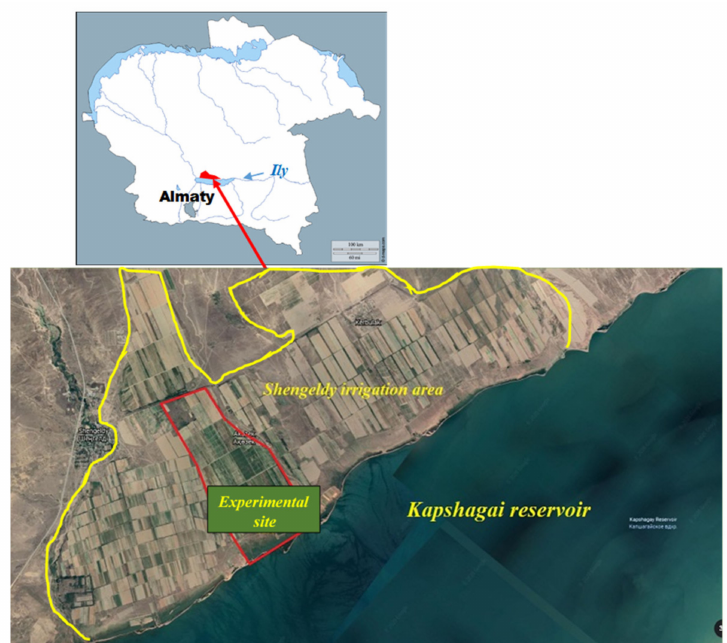
Figure 1. Shengeldy irrigation area